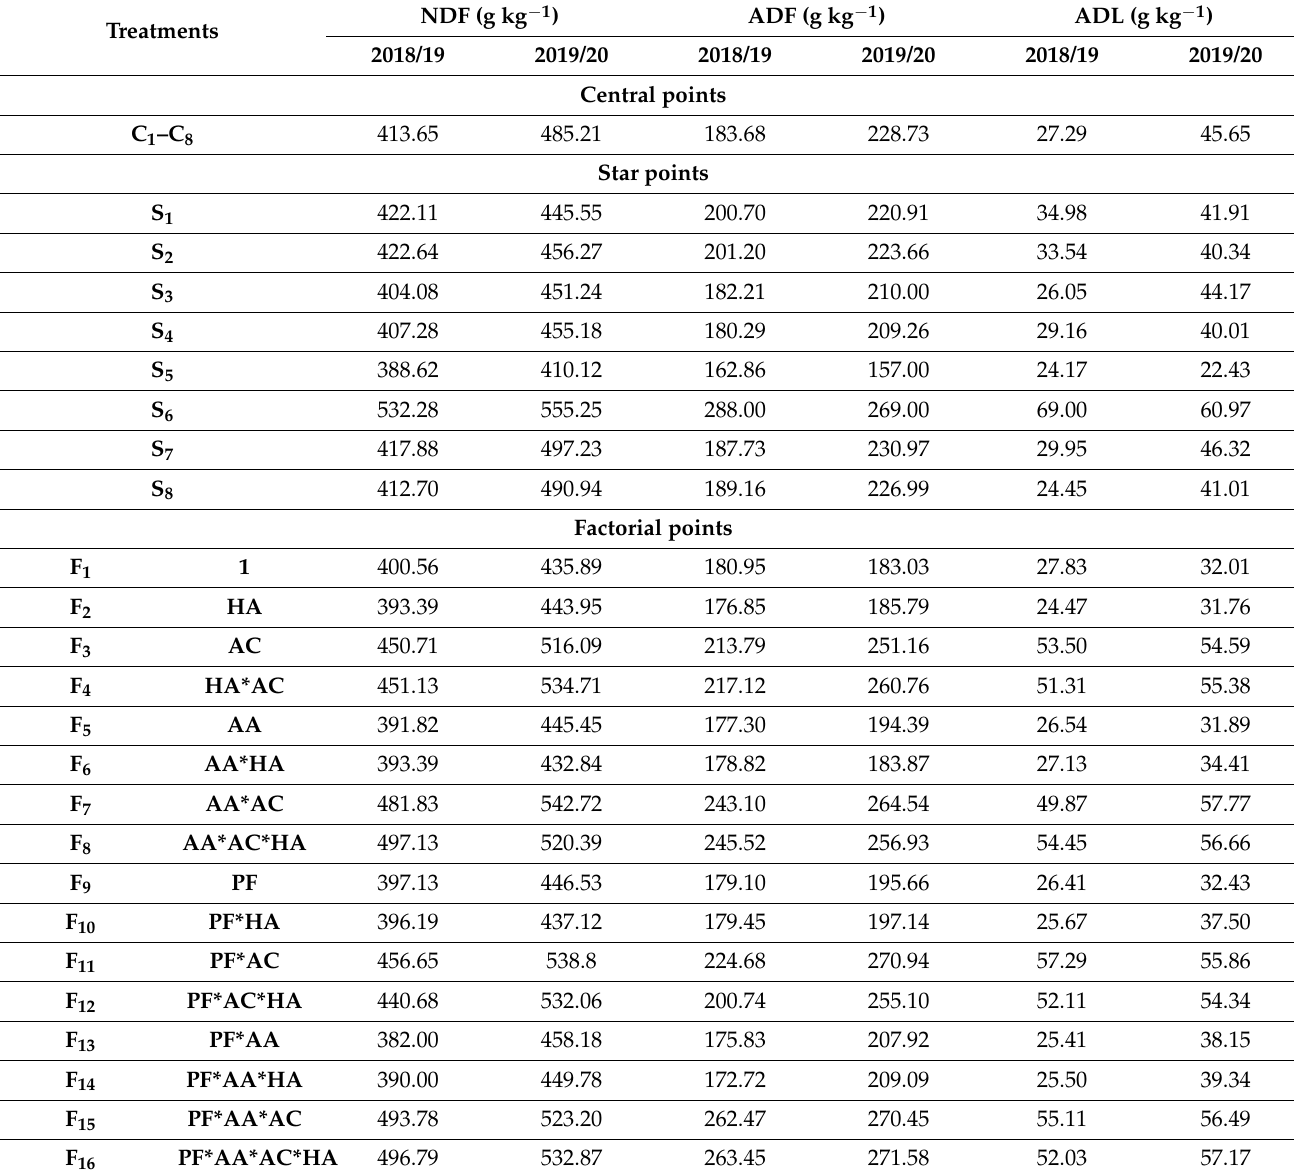
Table 6. Values of neutral detergent fiber (NDF), acid detergent fiber (ADF) and acid detergent lignin (ADL) as affected by levels of PF, AA, AC and HA and their interactions in 2018/19 and 2019/20.